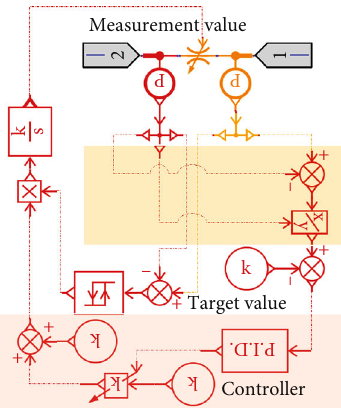
Figure 18: The PID control structure and function simulation model of the pintle injector.